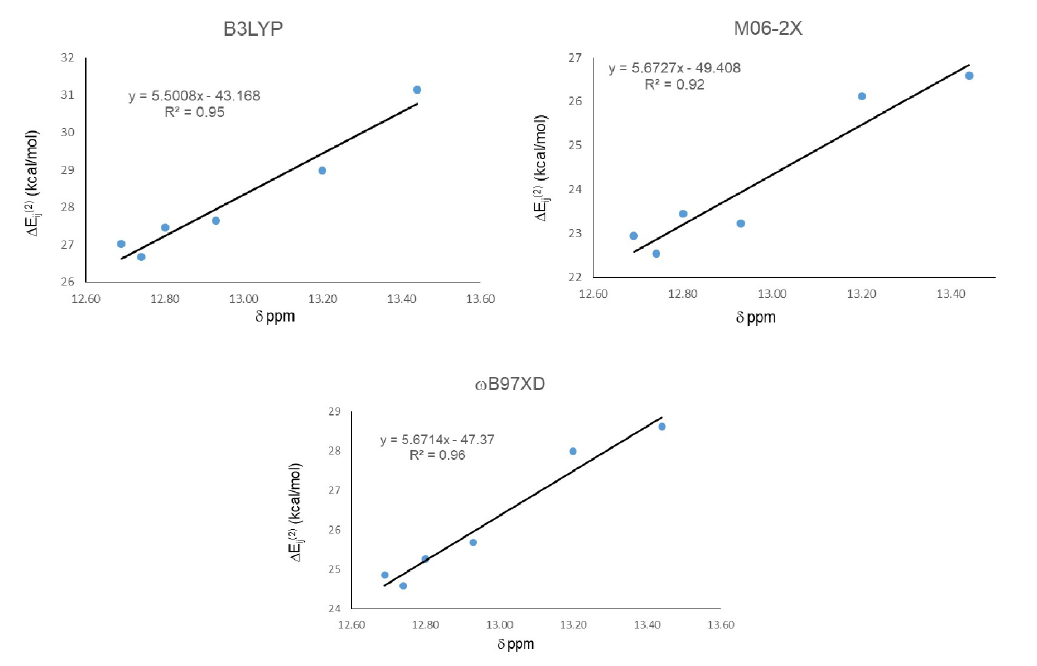
Figure 6. Correlations between second order stabilization energies ∆ E ij(2) LP O 15 → σ * O 11 -H 16 and experimental chemical shifts (δ) of protons involved in IMHB, excluding the weakest value.